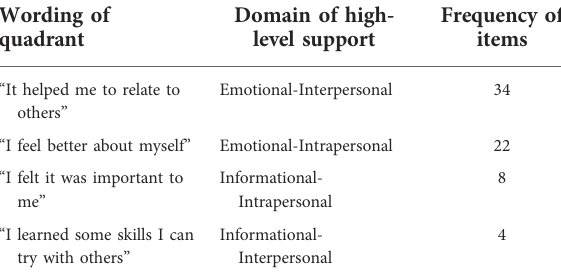
TABLE 3 Frequency of items categorization into high-level domains of support after round 1. Wording of quadrant